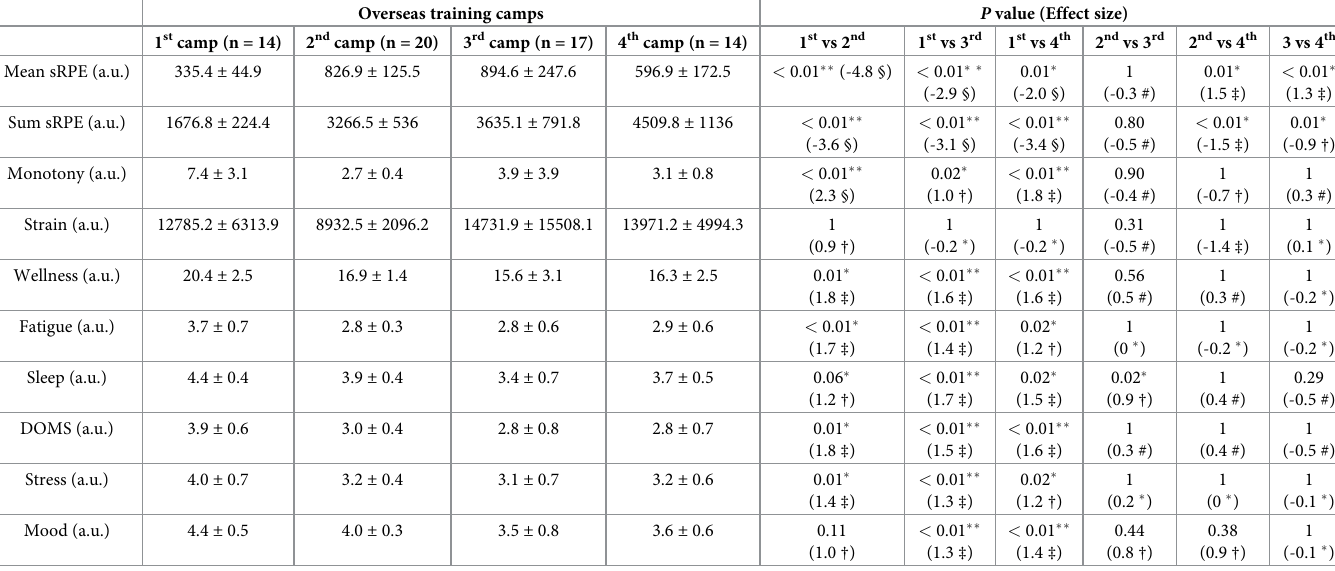
Table 2. Means of internal loads (session rating of perceived exertion, training monotony, and training strain) and wellness status (wellness, fatigue, delayed onset muscle soreness, sleep, stress, and mood) in four overseas training camps. Overseas training camps